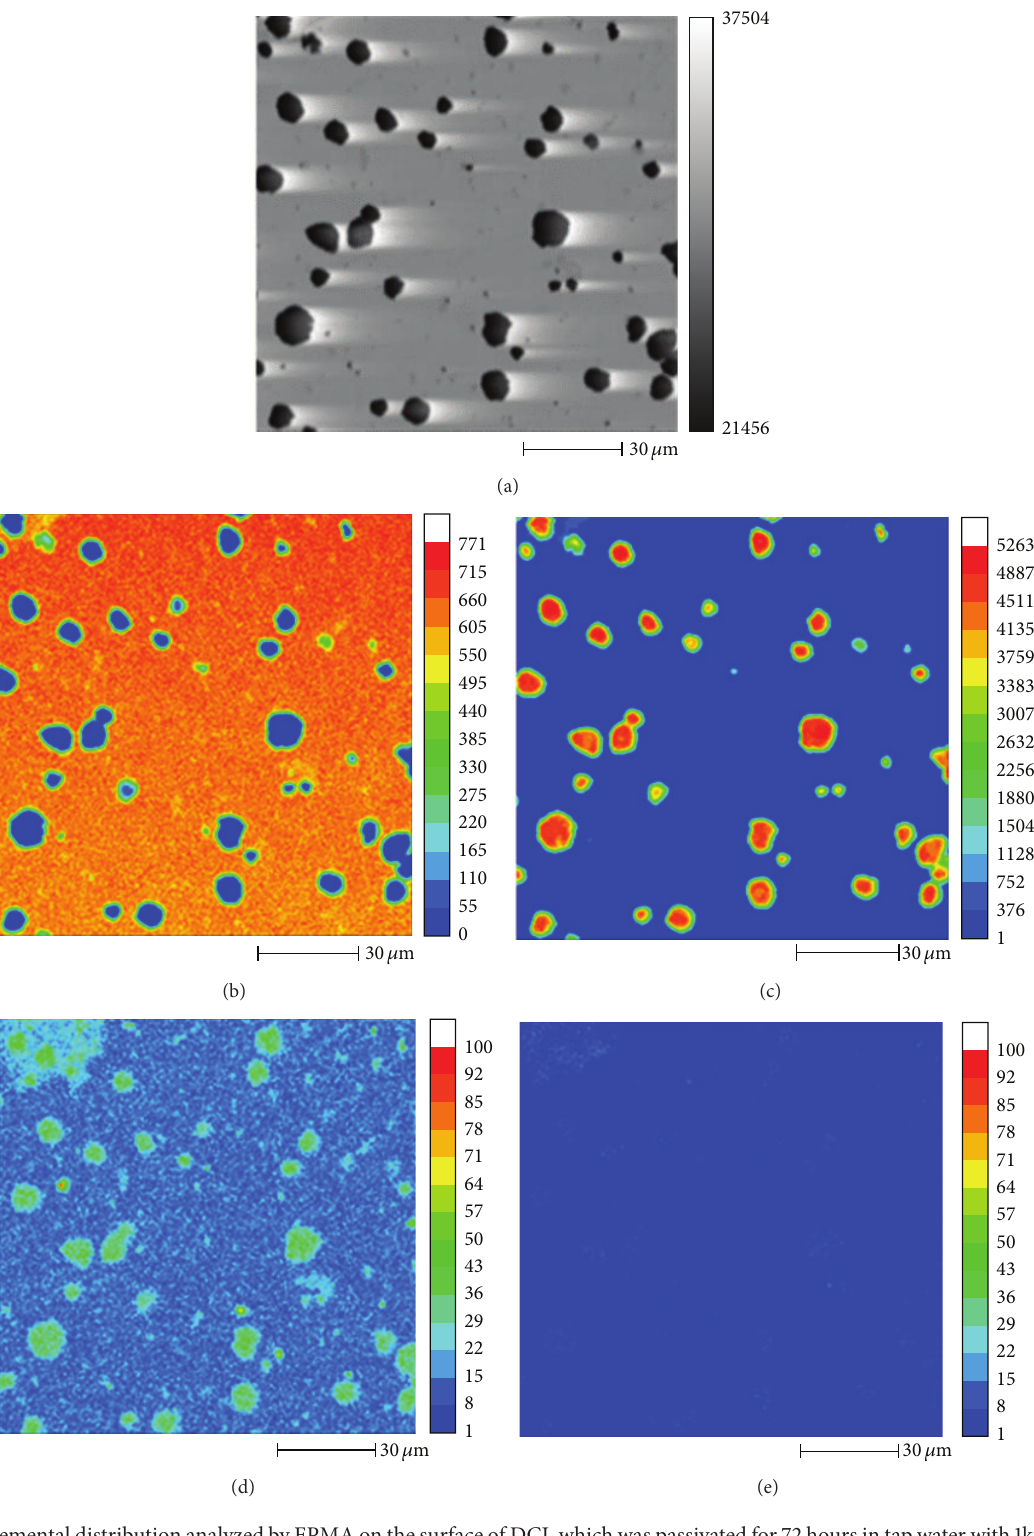
Figure 8: Elemental distribution analyzed by EPMA on the surface of DCI, which was passivated for 72 hours in tap water with 1kppm NO 2− + 2.5k ppm TEA at 25 ∘ C. (a) SEM image, (b) Fe, (c) C, (d) O, and (e)